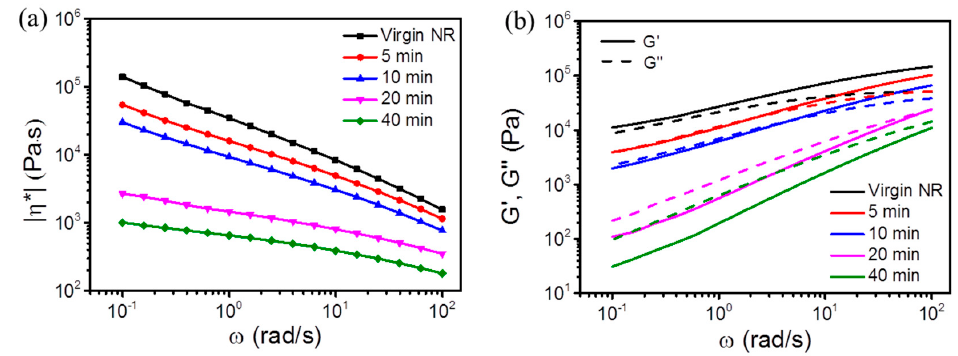
Figure 2. Variations of complex viscosity ( a ), storage modulus ( b , straight line) and loss modulus ( b , dashed line) as functions of angular frequency for masticated NR with various mixing time.